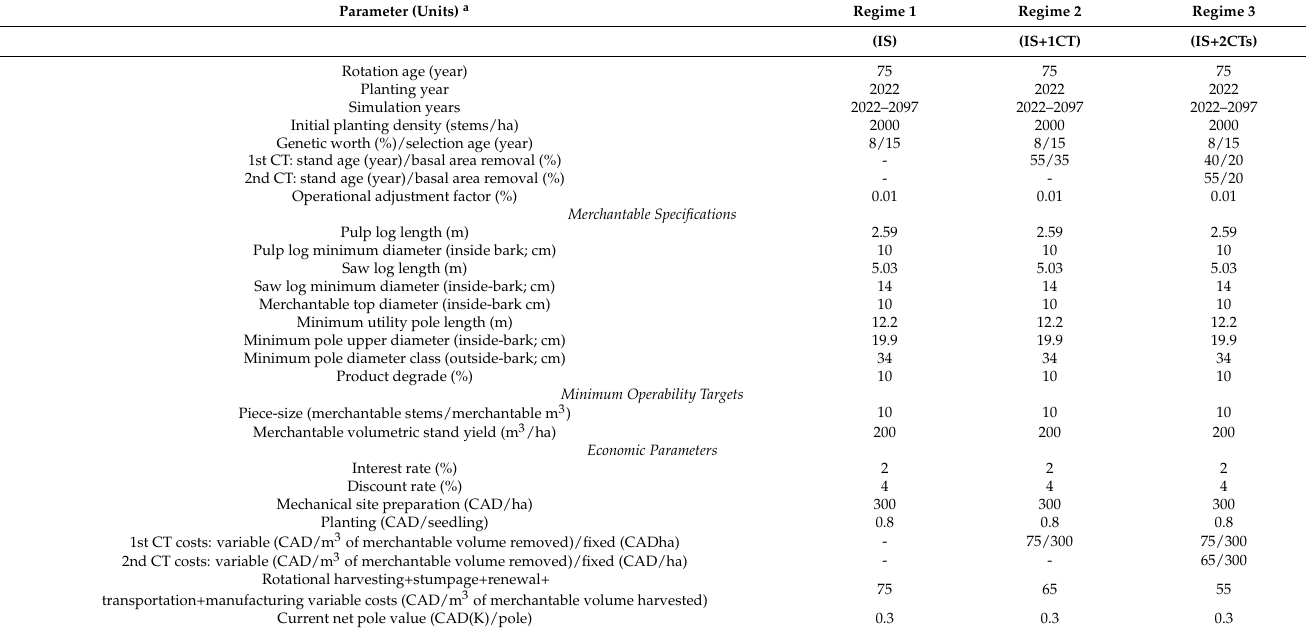
Table 2. Input parameters for the SSDMM simulations for red pine plantations growing on medium- to-good quality